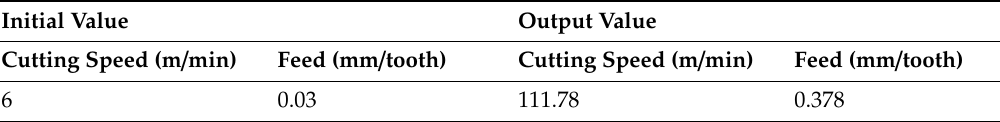
Table 10. Results by using optimum parameters.